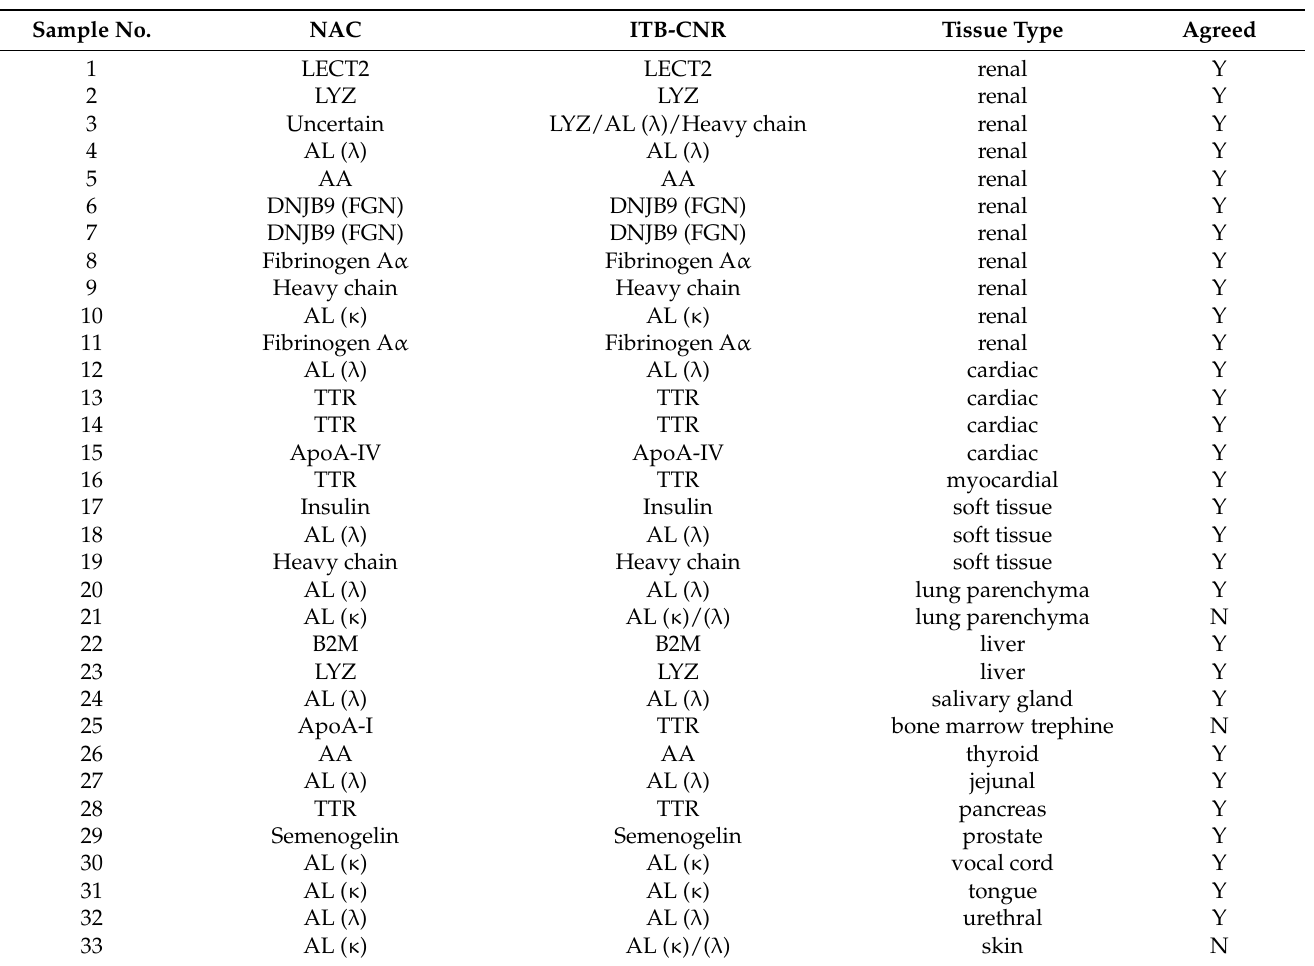
Table 1. National Amyloidosis Centre (NAC) proteomics data analysed by Istituto di Tecnologie Biomediche-Consiglio Nazionale delle Ricerche (ITB-CNR). The Table shows the proteomics results obtained by the single centres, and the analysed tissue types: formalin-fixed paraffin-embedded (FFPE) biopsies (samples from 1 to 33), fat aspirates (samples from 34 to 40), and the agreement of final results between the two centres. Sample